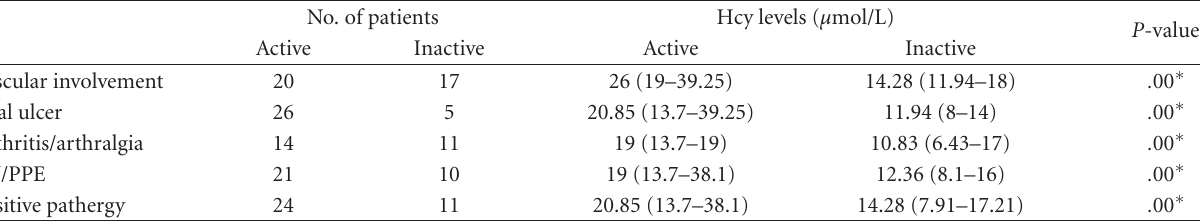
Table 9: Comparison of Hcy between groups of active and inactive patients according to the presence of individual clinical manifestations and positive